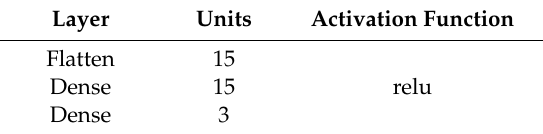
Table 6. MLP: units and activation functions of each